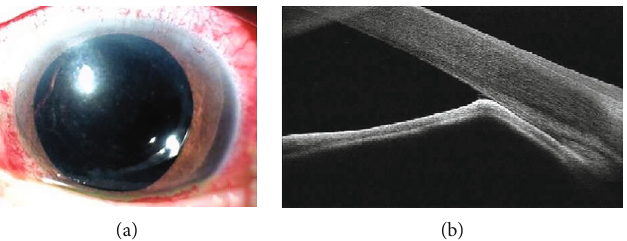
Figure 1: (a) Anterior segment photograph of the left eye showing 270 ° of iridocorneal apposition in the periphery of the anterior chamber. (b) Anterior segment optical coherence tomography of the left eye showing iridocorneal apposition.